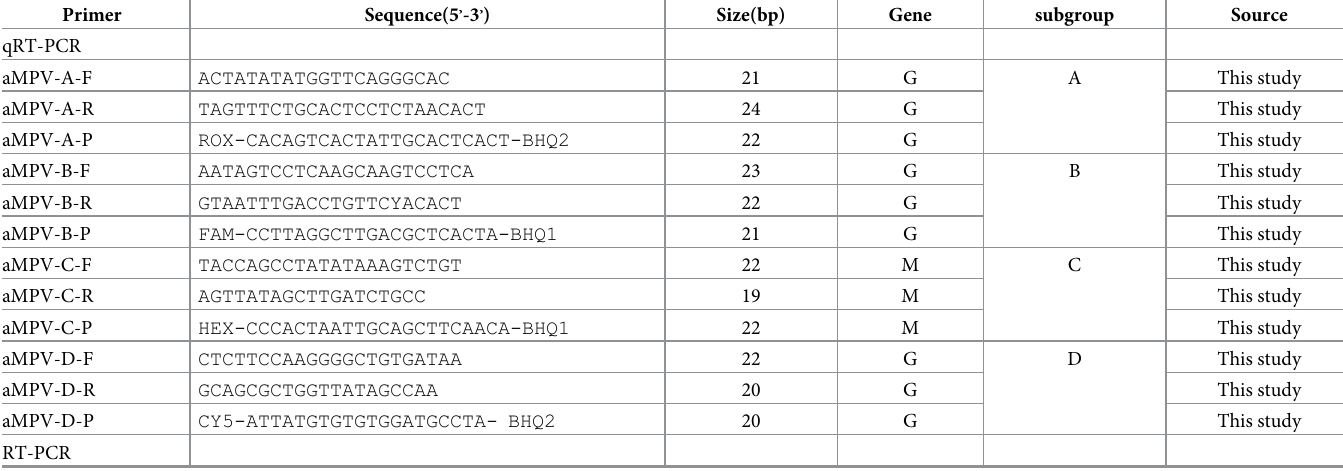
Table 1. Primers and probe sequences used for real-time RT-PCR and RT-PCR.